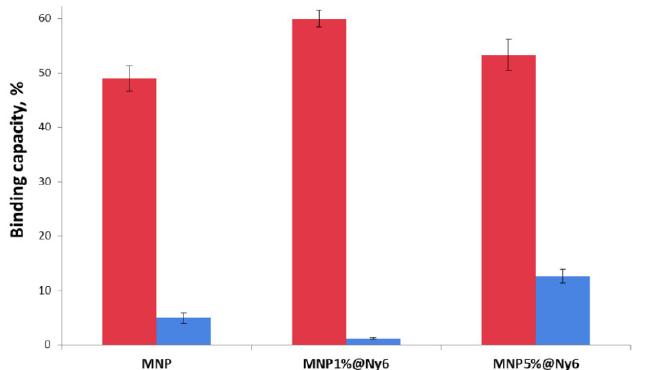
Figure 6. Binding capacity on MNP and MNP@Ny6 in percent for FAM-RNA isolation. Red—nanocomposites with oligonucleotide No. 1 (specific for RNA target), Blue—nanocomposites with oligonucleotide No. 2 (nonspecific). Initial amount of FAM-RNA is 0.30 nmol (see Table